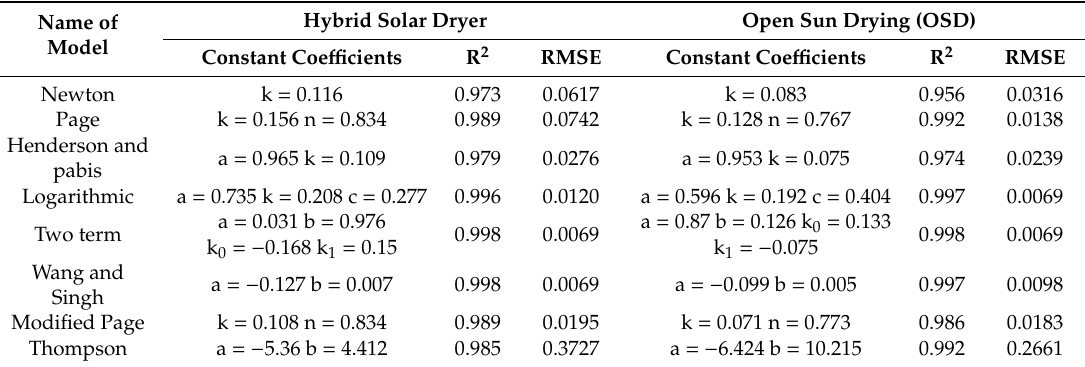
Table 5. Non-linear regression analyses for lemon slices’ drying.